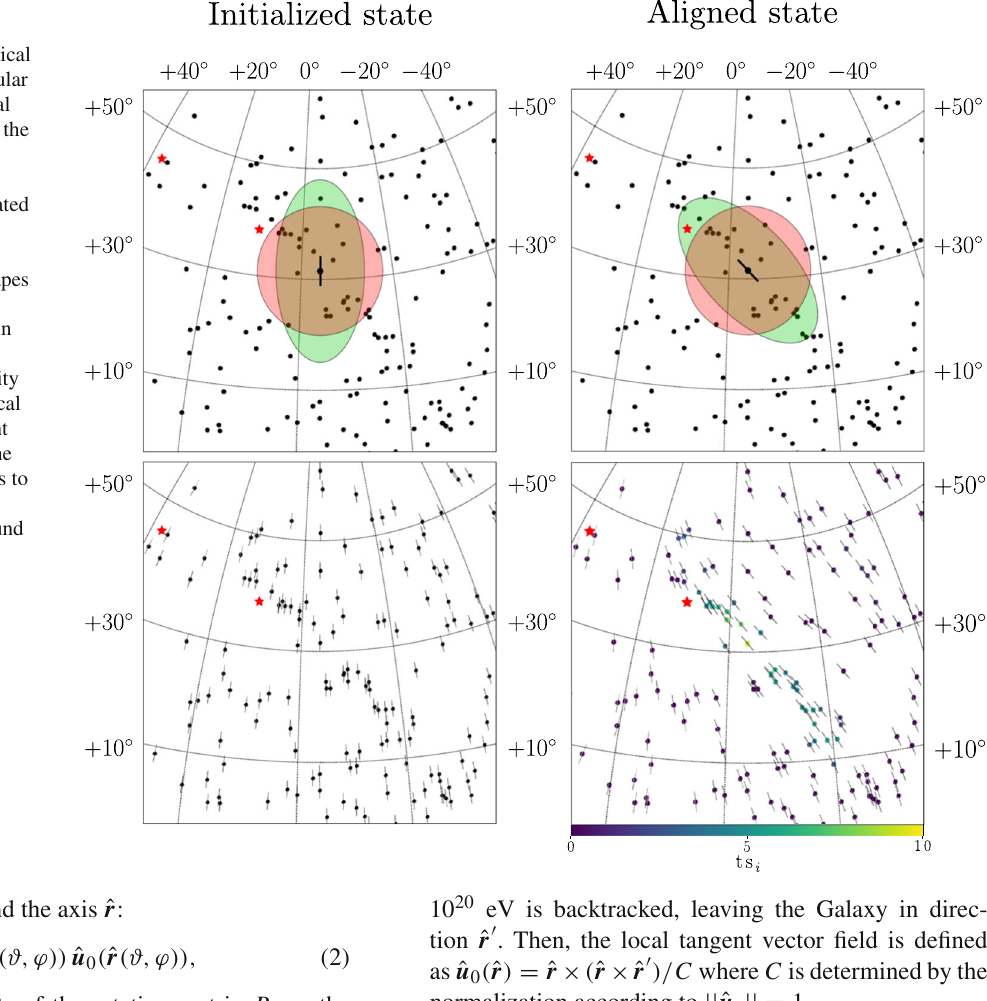
by a rotation of ˆ u 0 around the axis ˆ r